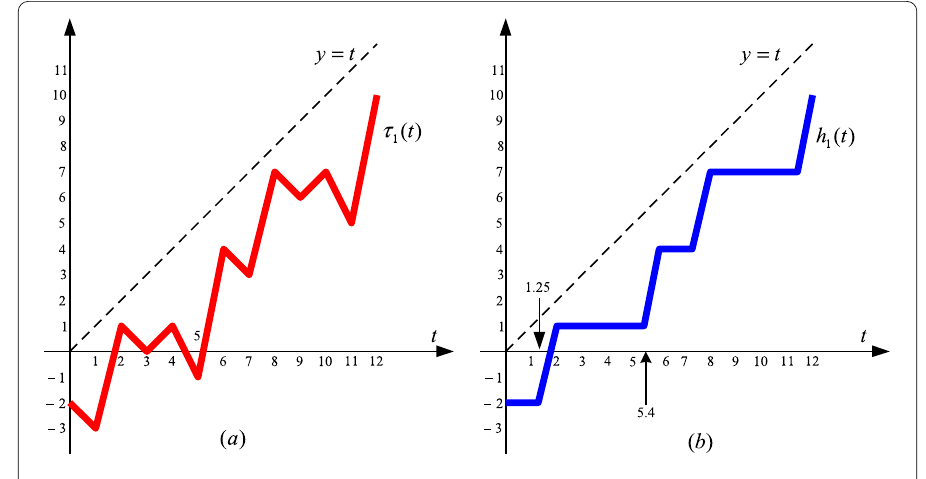
Figure 1 The graphs of τ 1 ( t ) and h 1 ( t